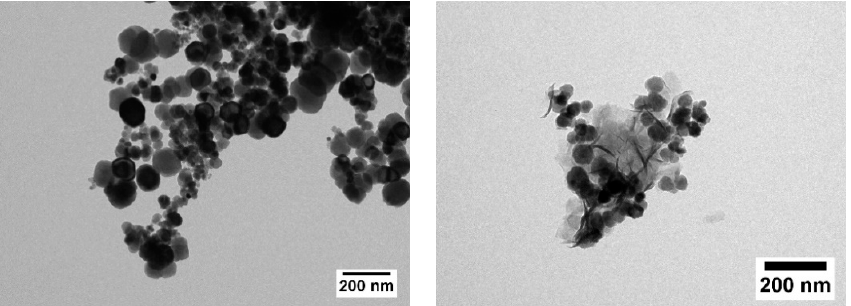
Figure 3. Typical TEM images for S35 ( left ) and S75 ( right ). An additional phase besides the MNP can be seen in S75.